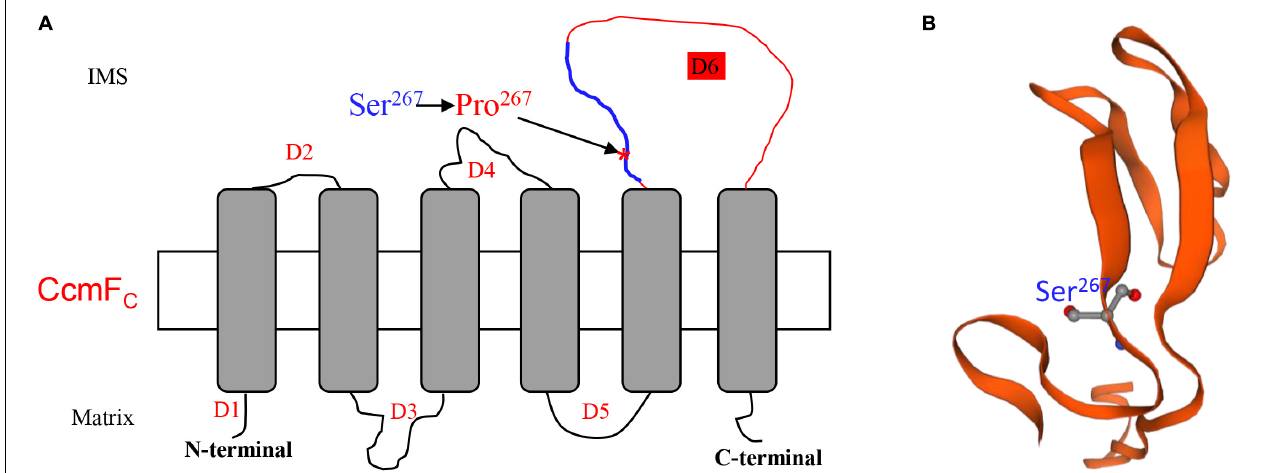
FIGURE 8 | Ser 267 is in the third intermembrane space loop named Domain 6 (D6). (A) Topology model of ZmCcmFC predicted by TMHMM Server v. 2.0 (http://www.cbs.dtu.dk/services/TMHMM/). The Ser 267 was marked by arrow. D1-6, Domain1-6; IMS, Intermembrane space. (B) The predicted protein structure of peptide from 258th to 302th in ZmCcmFC marked by blue line in (A)